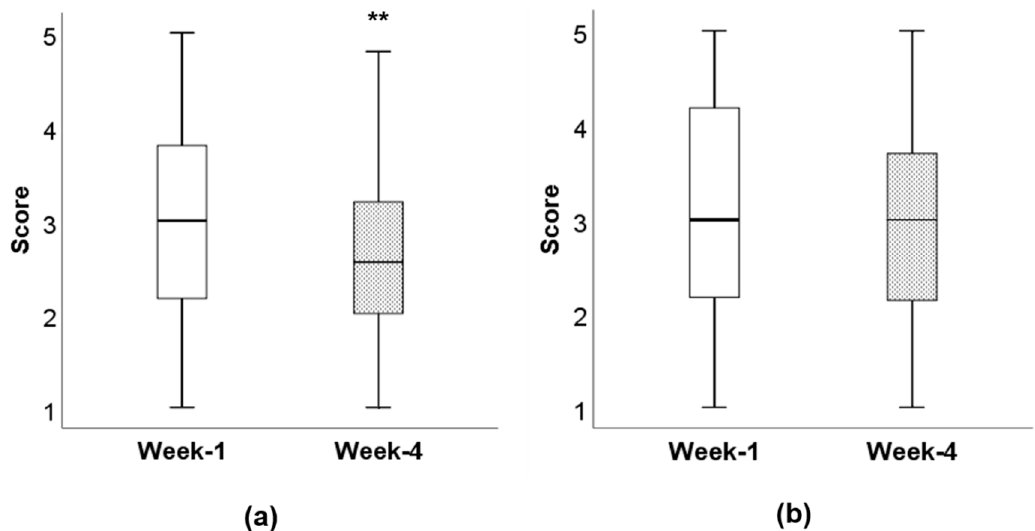
Figure 2. Food fussiness scores at week 1 and time week 4: ( a ) food fussiness scores in the intervention group at week 1 and week 4, ** p = 0.002. ( b ) Food fussiness scores in the comparison group at week 1 and week 4, p = 0.400. Scores are an average of six items; scores ranged from 1 to 5 for “completely disagree” to “completely agree”.